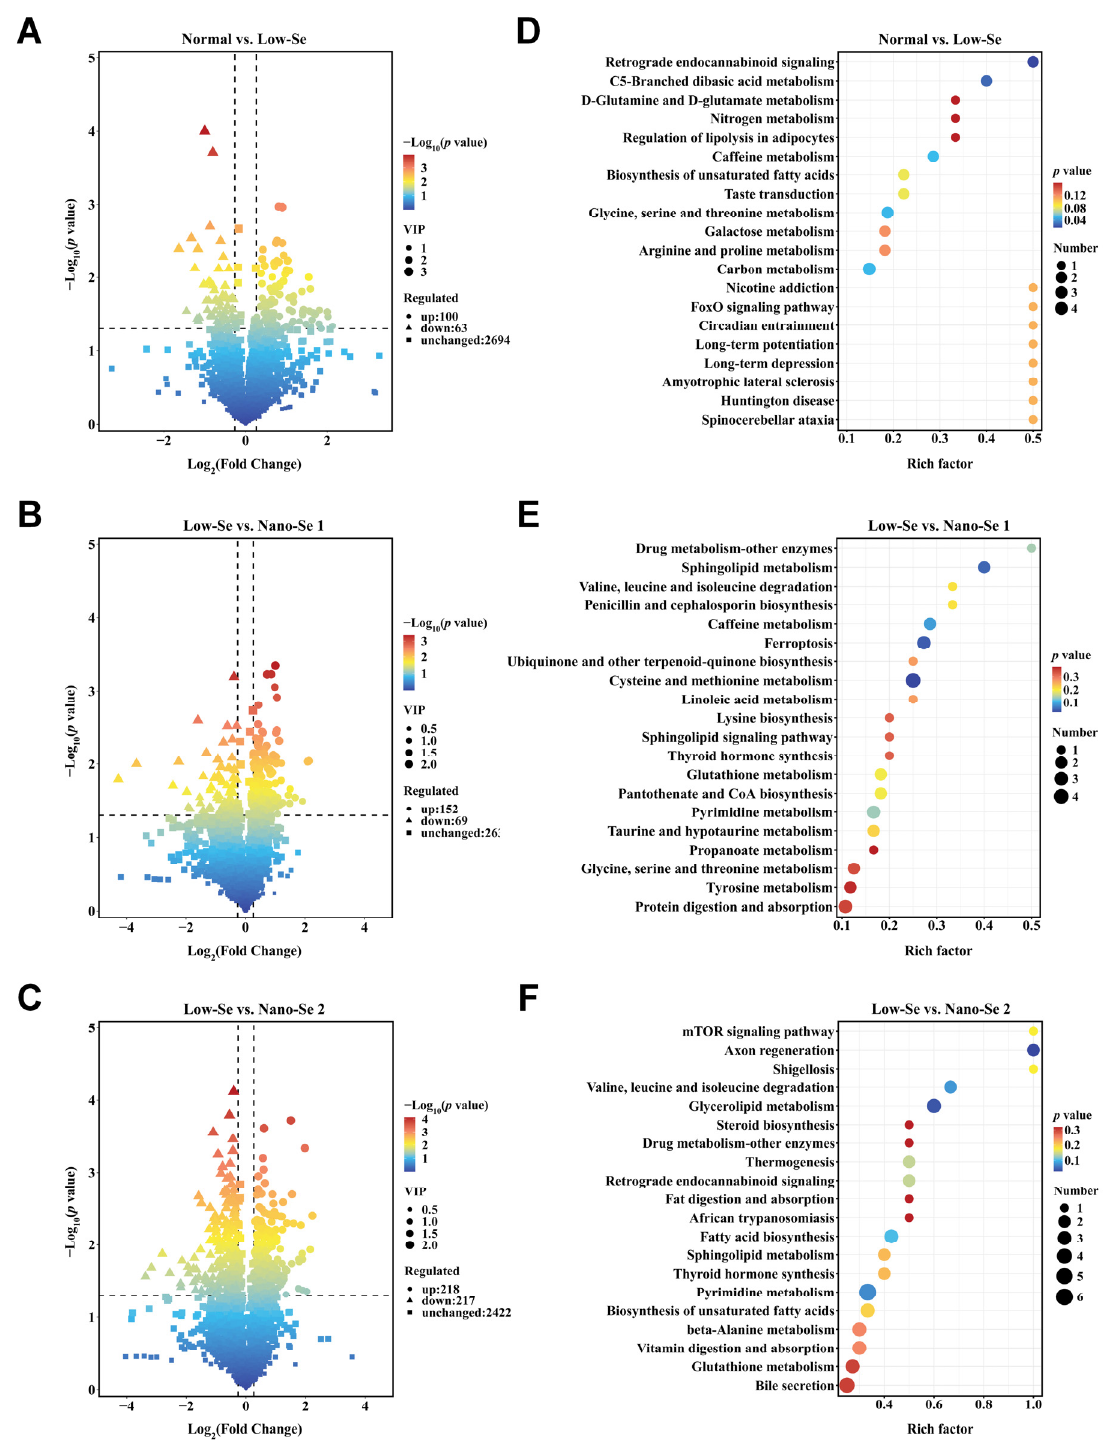
Figure 3. Expression of differential metabolites and KEGG enrichment analysis between different groups. ( A – C ) Volcano plots of differential metabolites expression in the normal group vs. low-Se group, low-Se group vs. nano-Se supplement-1 group, and low-Se group vs. nano-Se supplement-2 group. ( D – F ) Top 20 rich factors of KEGG enrichment analysis results for metabolites differentially expressed in the normal group vs. low-Se group, low-Se group vs. nano-Se supplement-1 group, and low-Se group vs. nano-Se supplement-2 group. Se: selenium; KEGG: Kyoto Encyclopedia of Genes and Genomes, VIP: variable importance for the